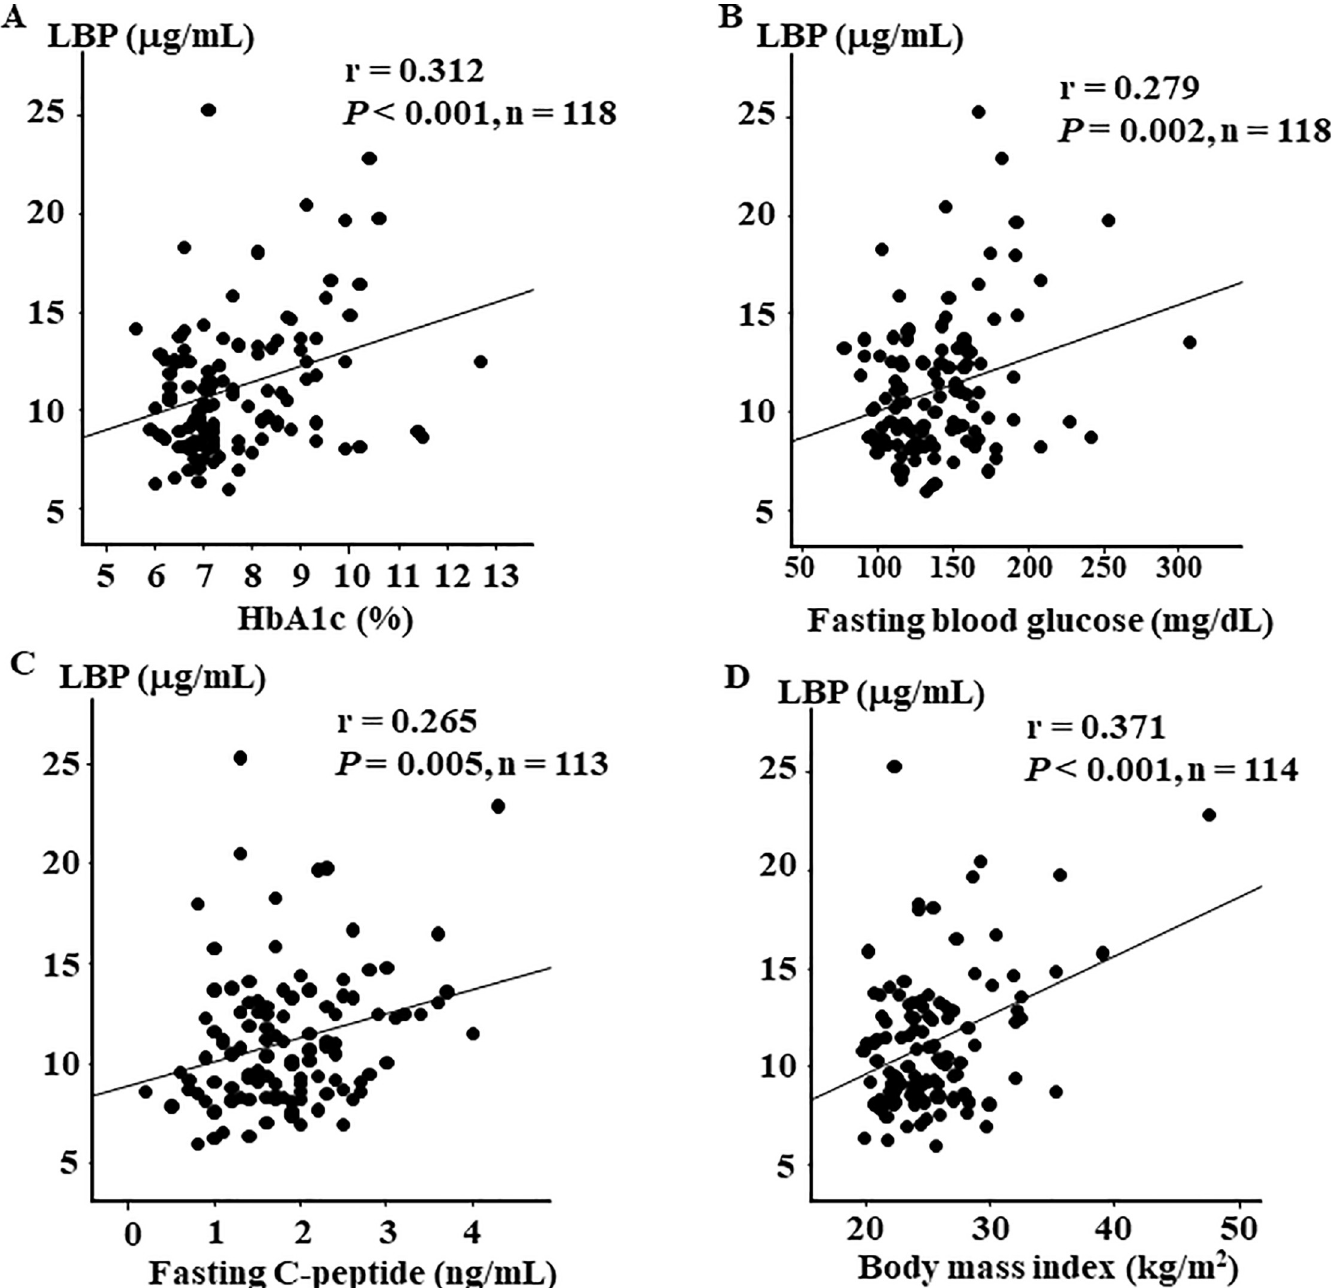
Fig 1. Correlations between LBP, glycemic control, and body mass index. Correlation between (A) LBP and HbA1c (r = 0.312, P < 0.001, n = 118), (B) LBP and fasting blood glucose (r = 0.279, P = 0.002, n = 118), (C) LBP and fasting C-peptide (r = 0.265, P = 0.005, n = 113), and (D) LBP and body mass index (r = 0.371, P < 0.001 n =